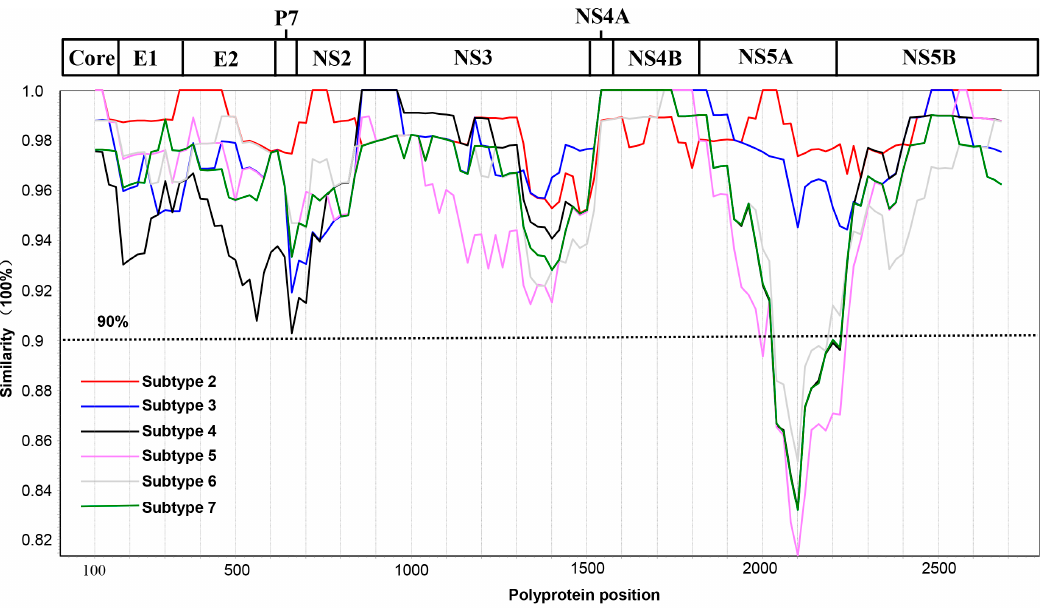
Figure 1. SimPlot analysis of BovHepV strains of subtypes A – G based on polyprotein. A schematic of the genome organization of BovHepV is shown above. The results of pairwise polyprotein comparisons of BovHepV subtype A against subtypes B – G are indicated. The cut-off value of 90% amino acid identity is shown by the dotted line. The strain names and accession numbers of the BovHepV strains of subtypes A – G are listed in Table 3.